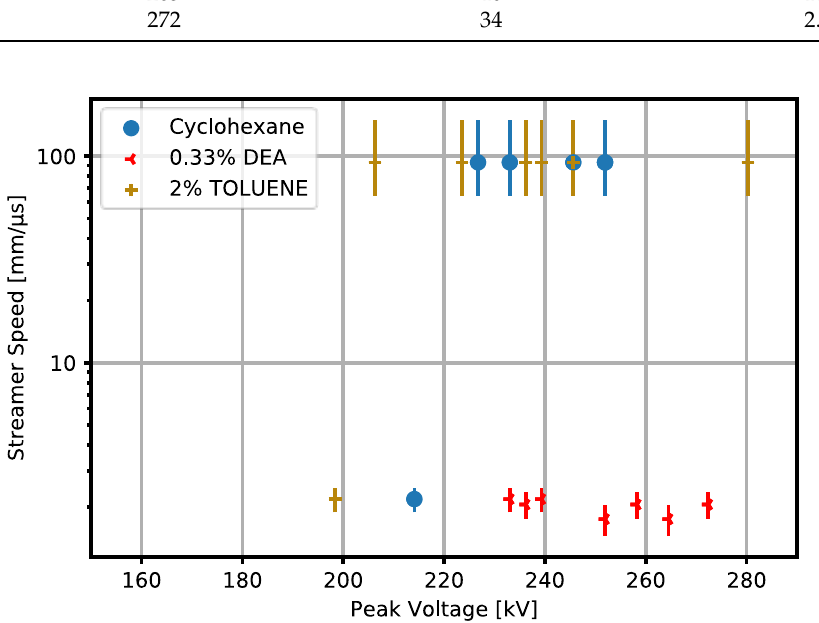
Figure A5. The approximate overall streamer velocity of streamers for cyclohexane and mixtures of cyclohexane with 0.33% DEA and 2% toluene. Applied voltage was a positive polarity lightning impulse (1.2/50 µs) with a 70 mm gap (point-plane arrangement). This data serves as a check of the repeatability of the results presented in Section 3.4, as a new needle and new batches of liquids were used.